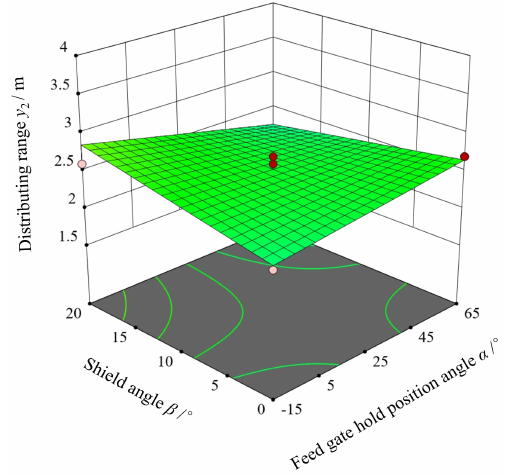
Figure 15. The effect of interaction factors on distributing